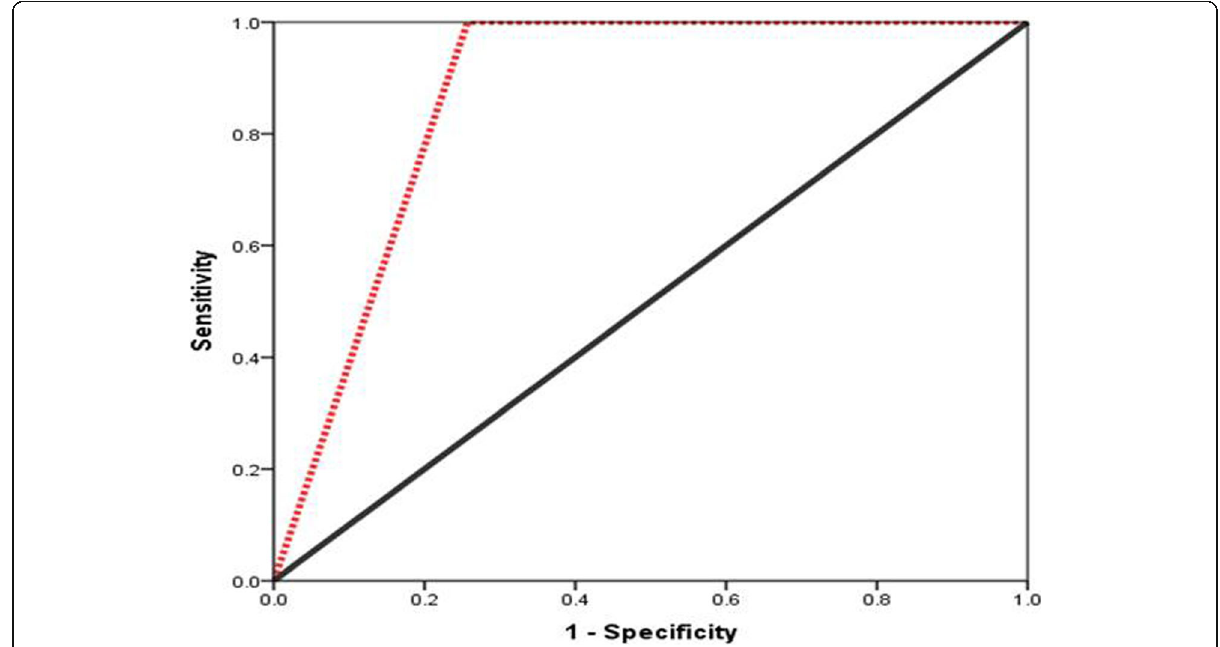
Fig. 1 ROC curve for malignancy prediction via